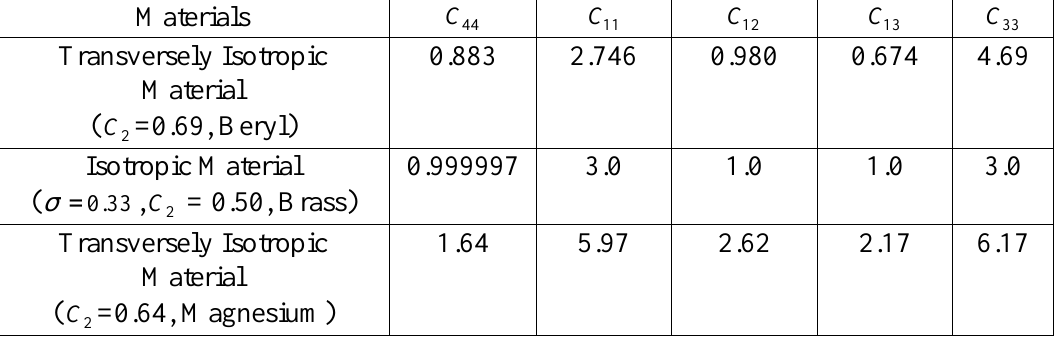
Table 1. Elastic constants